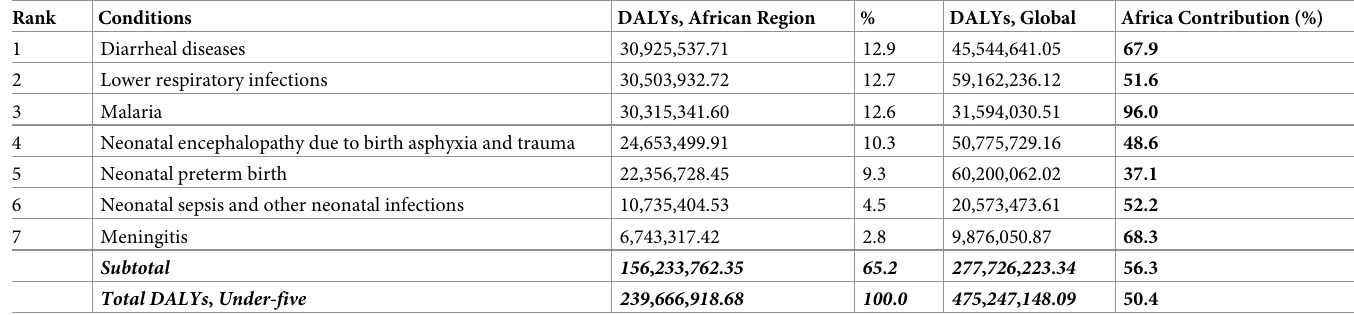
Table 4. Leading conditions in under-five year age cohort in the Africa region, global and African region DALYs contribution,